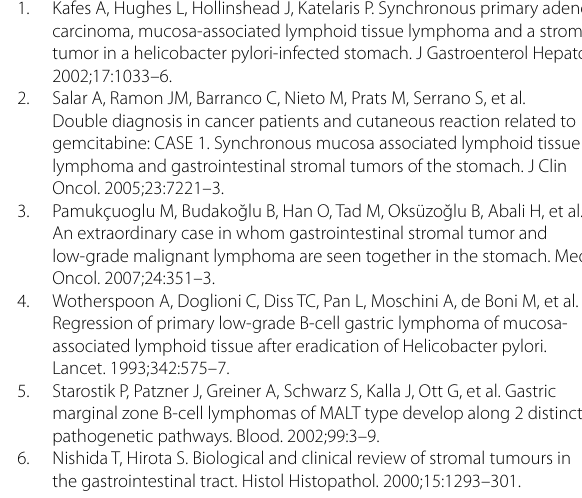
Abbreviations MALT: Mucosa-associated lymphoid tissue; H. pylori : Helicobacter pylori ; GIST: Gastrointestinal stromal tumor; DLBCL: Diffuse large B cell lymphoma; LEL: Lymphoepithelial lesion.